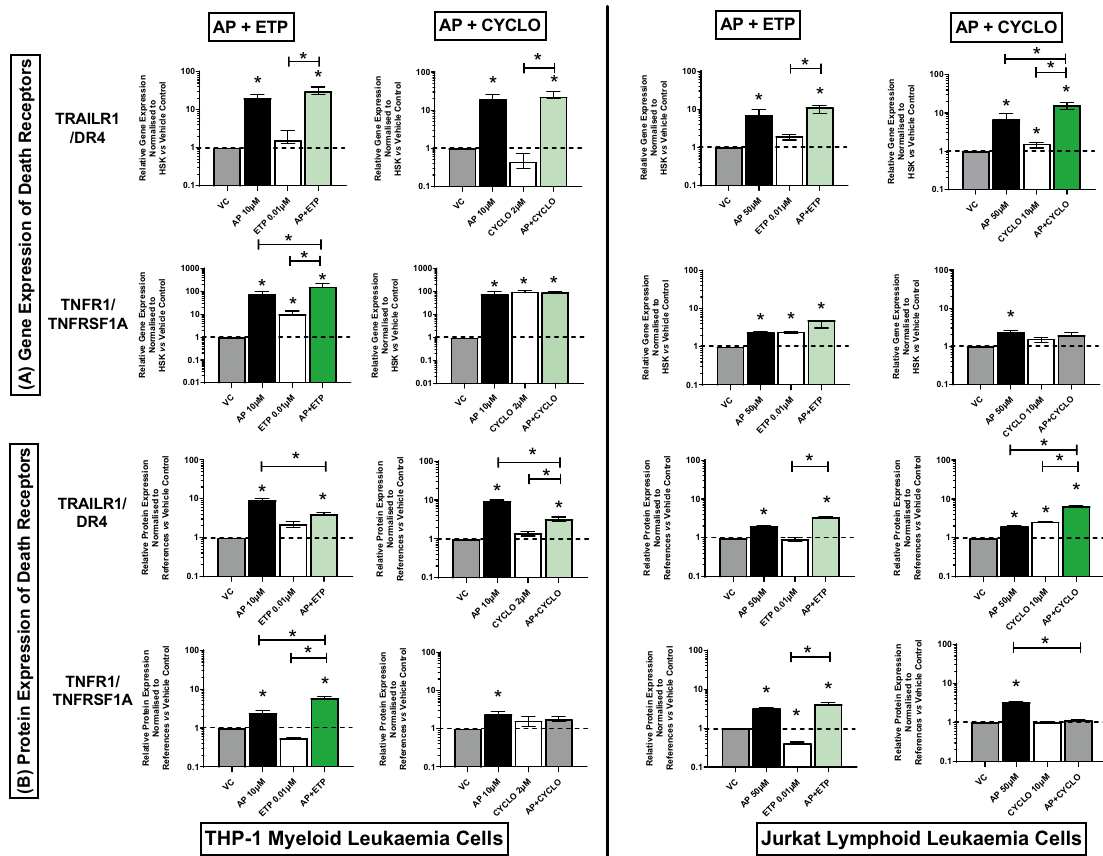
Figure 5. Effects of apigenin (AP) alone and in combination with etoposide (ETP) and cyclophosphamide (CYCLO) on expression of TRAILR1/DR4 and TNFR1/TNFRSF1A death receptors genes ( A ) and proteins ( B ) in acute myeloid (THP-1) and lymphoid (Jurkat) leukaemia cell lines when treated with their lowest significant doses (LSDs) that induce apoptosis (determined previously in Mahbub et al., 2013, 2015, 2019) for 24 h. Gene and protein data are expressed as medians and ranges. Results were considered statistically significant when P ≤0.05 (*). The combination treatment effects and colours were determined based on the statistical analysis as described